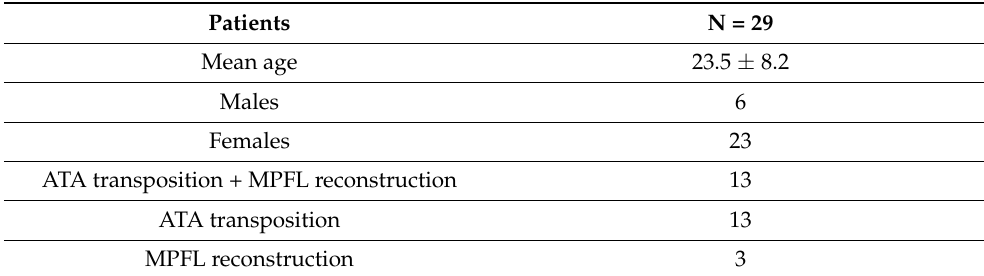
Table 1. Patients’ demographic and surgical procedures.